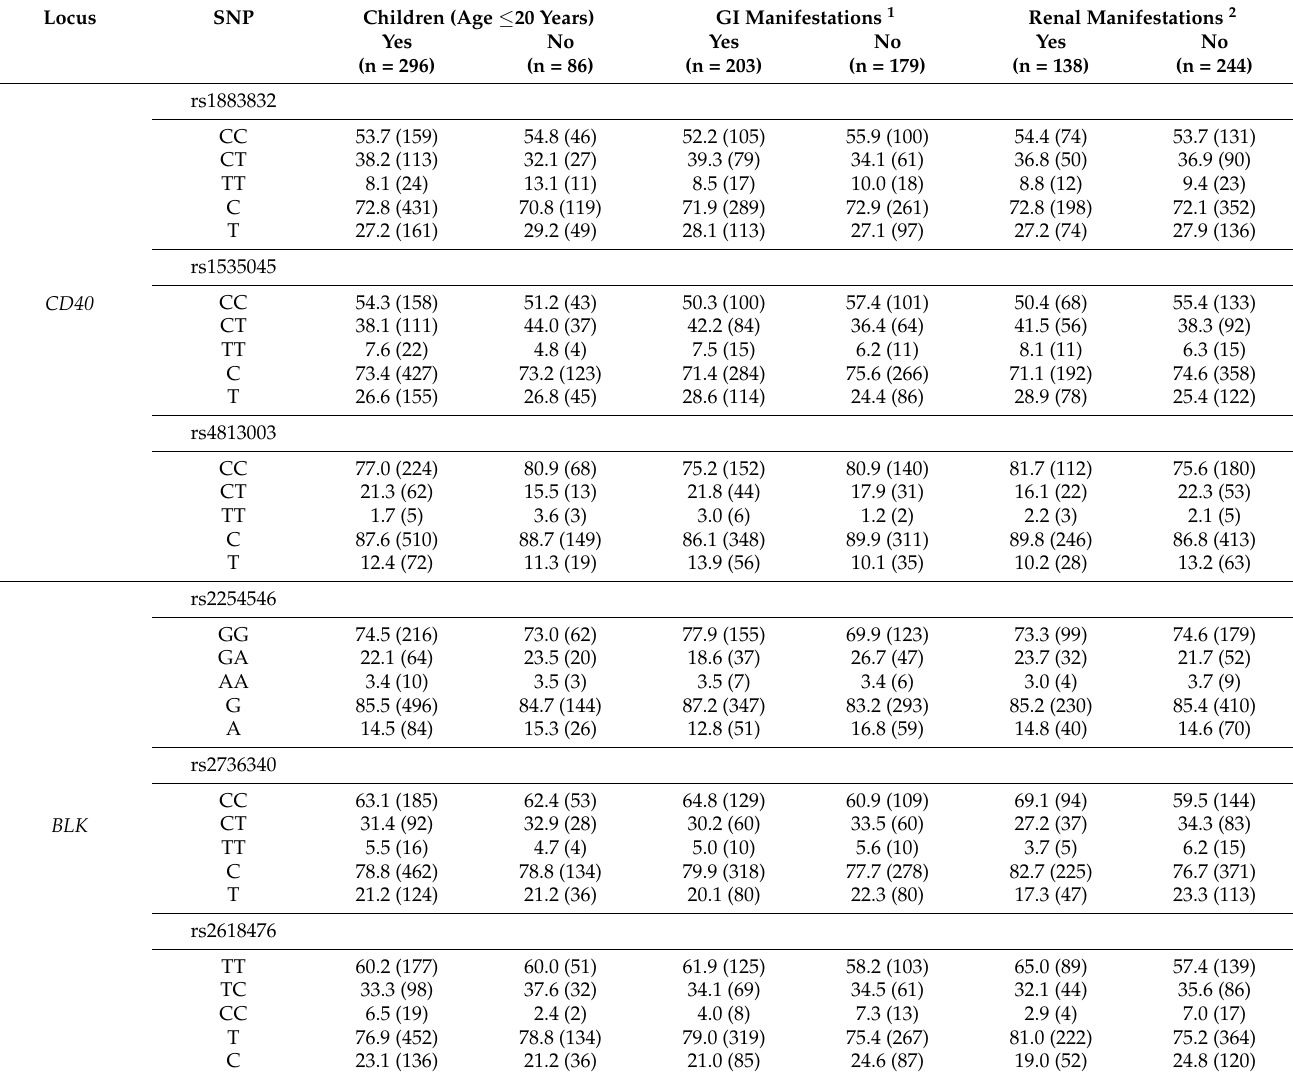
Table 3. CD40, BLK and BANK1 genotype and allele frequencies in IgAV patients stratified according to clinical